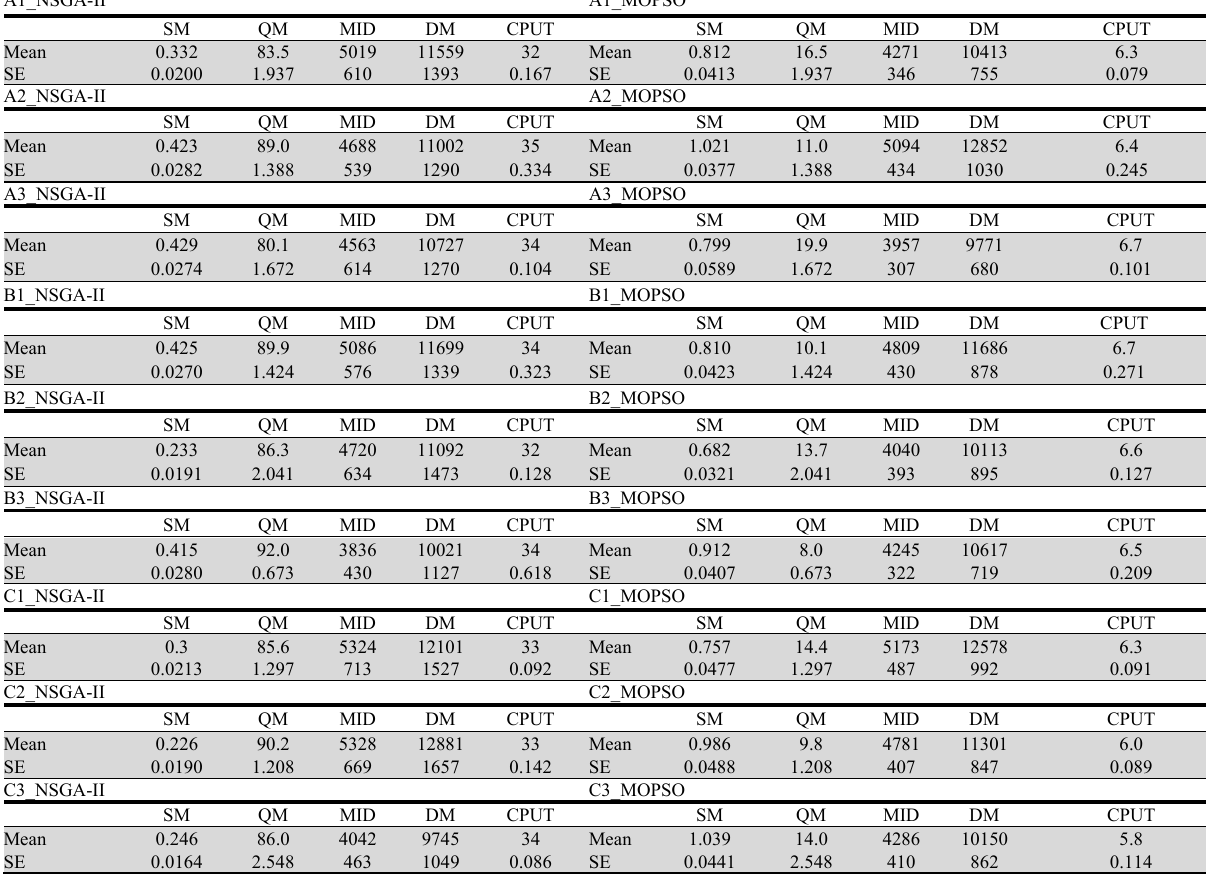
Fig. 15 Mean value for the two algorithms and small scale sample problems for each class SE and Mean values for the two algorithms in small scale sample problems for each